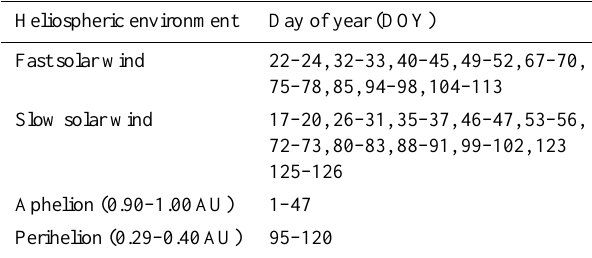
Table 1. Heliospheric environment encountered by Helios 2 in